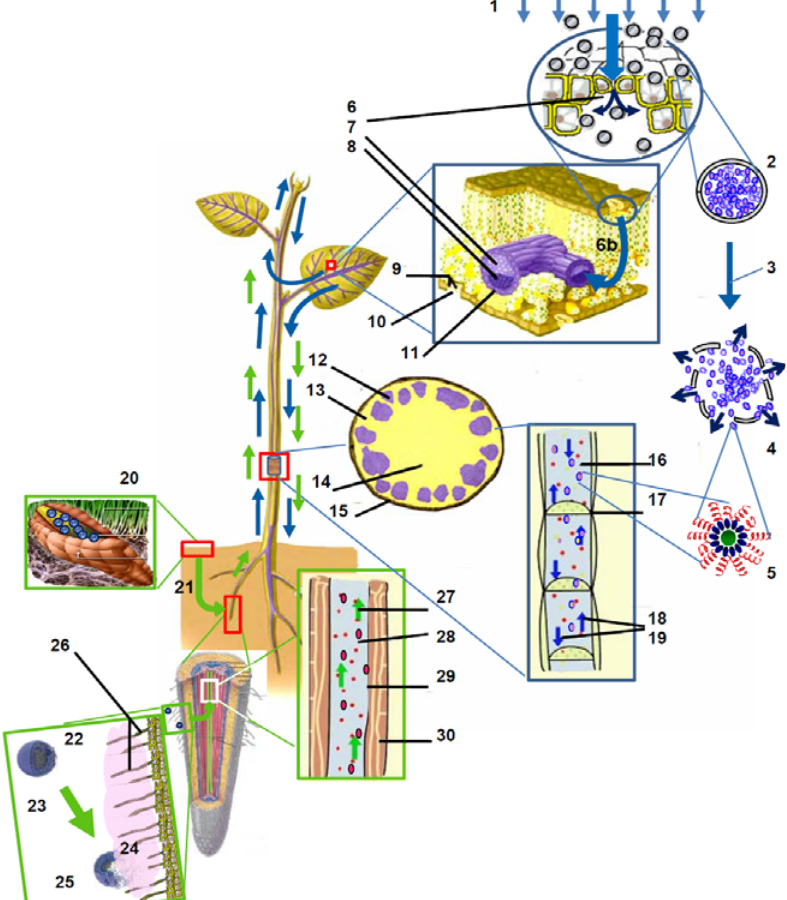
Figure 2. Illustration of two revolutionary avenues for the responsive polymer based delivery of the crop protection agents (CPAs) at nano- and microscale: (i) responsive release of bioinsecticides from polymer nanocapsules (PNC) regulated by plant stress enzymes, and (ii) smart delivery of nutrients from polymer microcapsules (PMC), self-adjusted by the intensity of plant root exudates